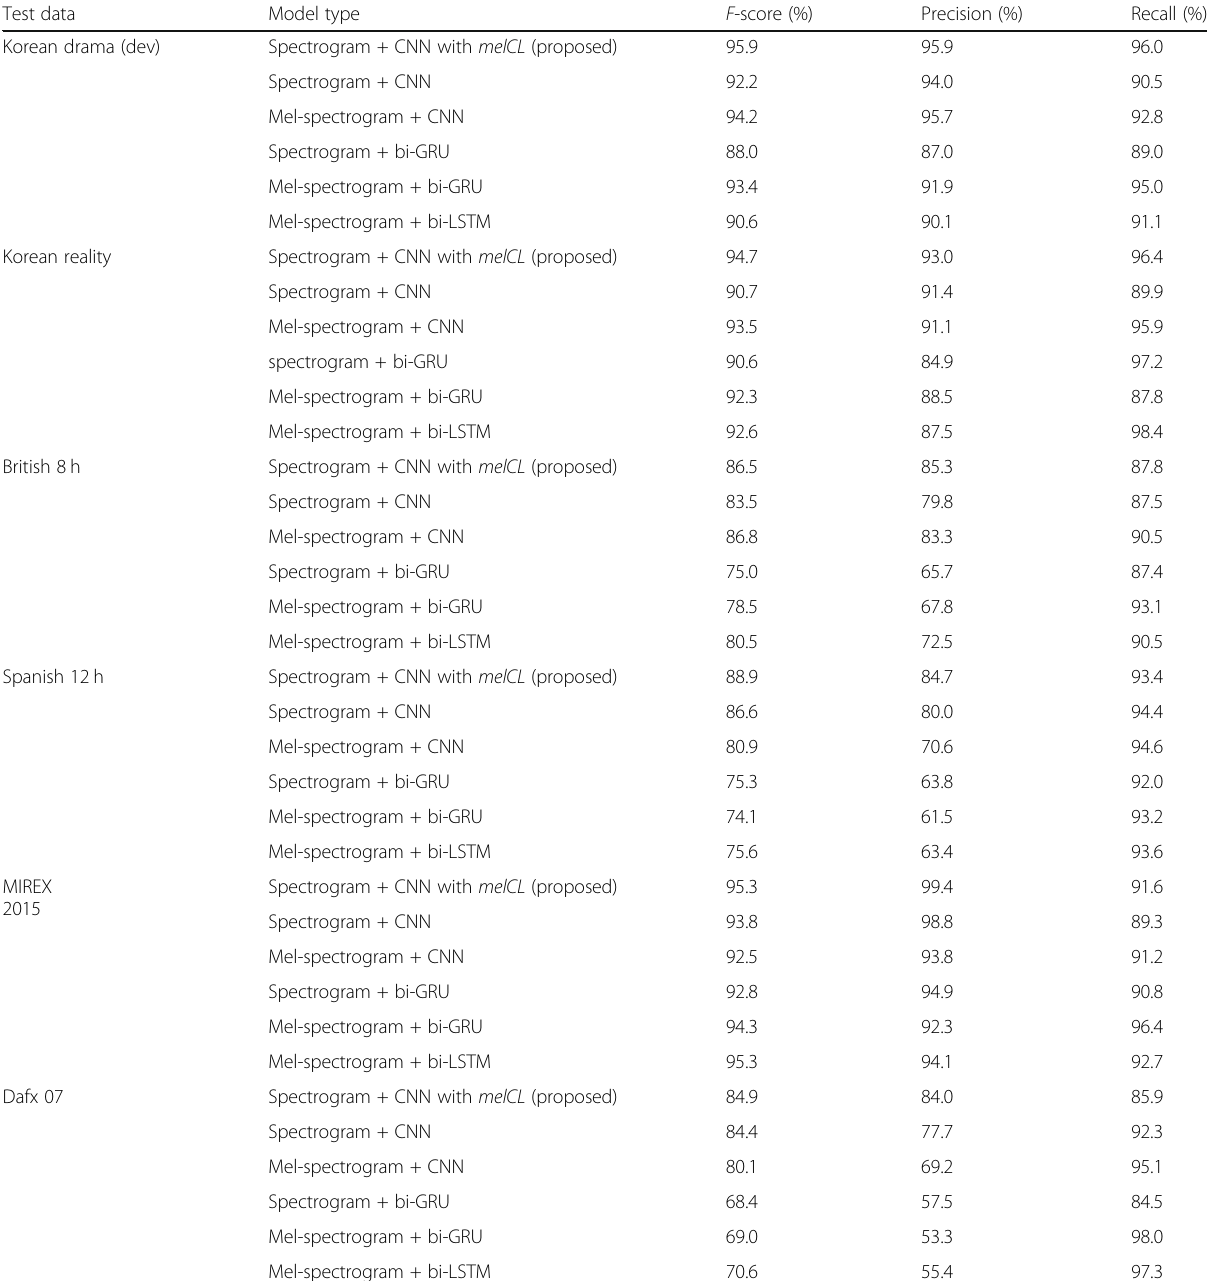
Table 3 Performance of the proposed and baseline systems Test